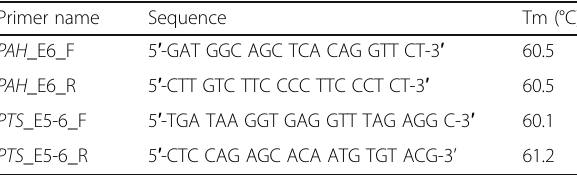
Table 2 Primer sequences for Sanger sequencing of novel